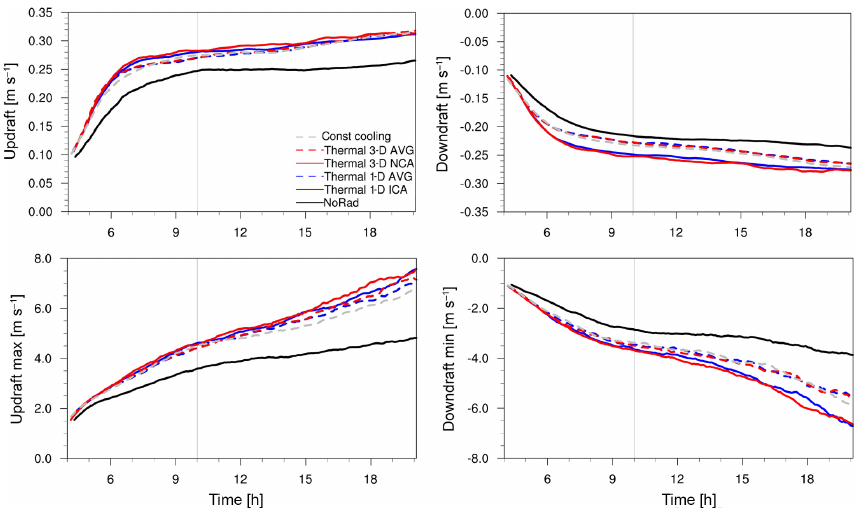
Figure 12. Time series of averaged vertical velocity as well as maximum updraft and downdraft vertical velocity of updrafts and